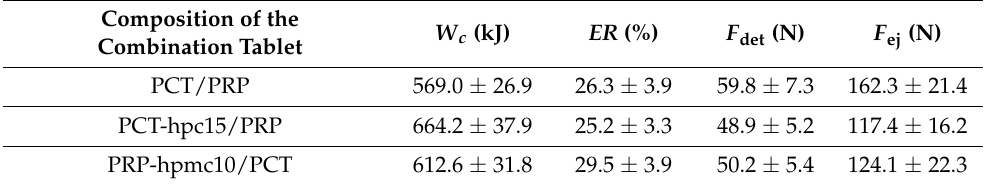
Table 5. Results of “in-die” measured parameters for tablets of optimal co-spray dried/neat compositions. Composition of the Combination